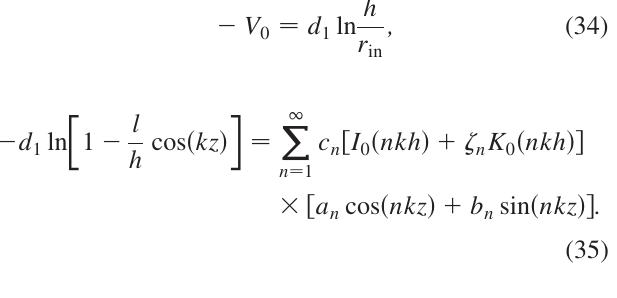
r=6.04 mm solid line--analytical formula dashed line--CST simulation